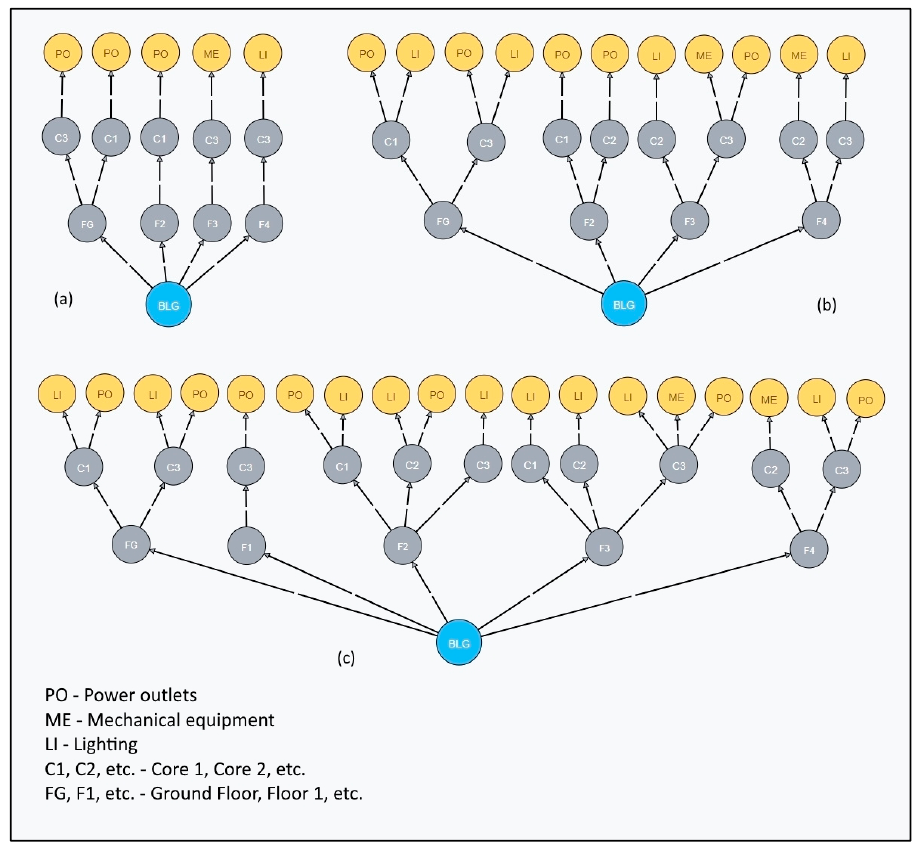
Figure 8. An evolution of the graph network when the database is used to model only the topology derived for the USB, showing its growth from state ( a ) to ( b ) and then ( c ) as more messages are received from data